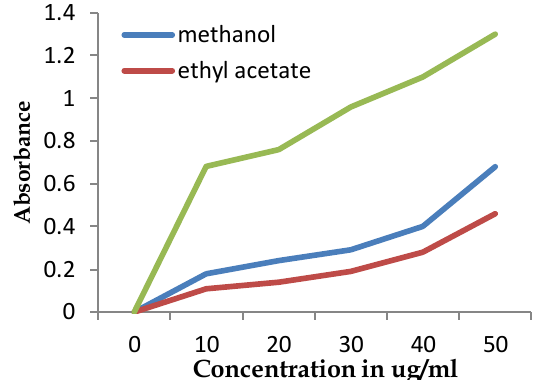
Figure 3 : Ferric reducing power activity of leaf extract of Bryophyllum pinnatum VIT C: Y = 0.227X + 0.004; R 2 = 0.886 Methanol: Y= 0.151X – 0.123; R 2 = 0.991 Ethyl acetate Y = 0.- 0.110; R 2 = 0.984